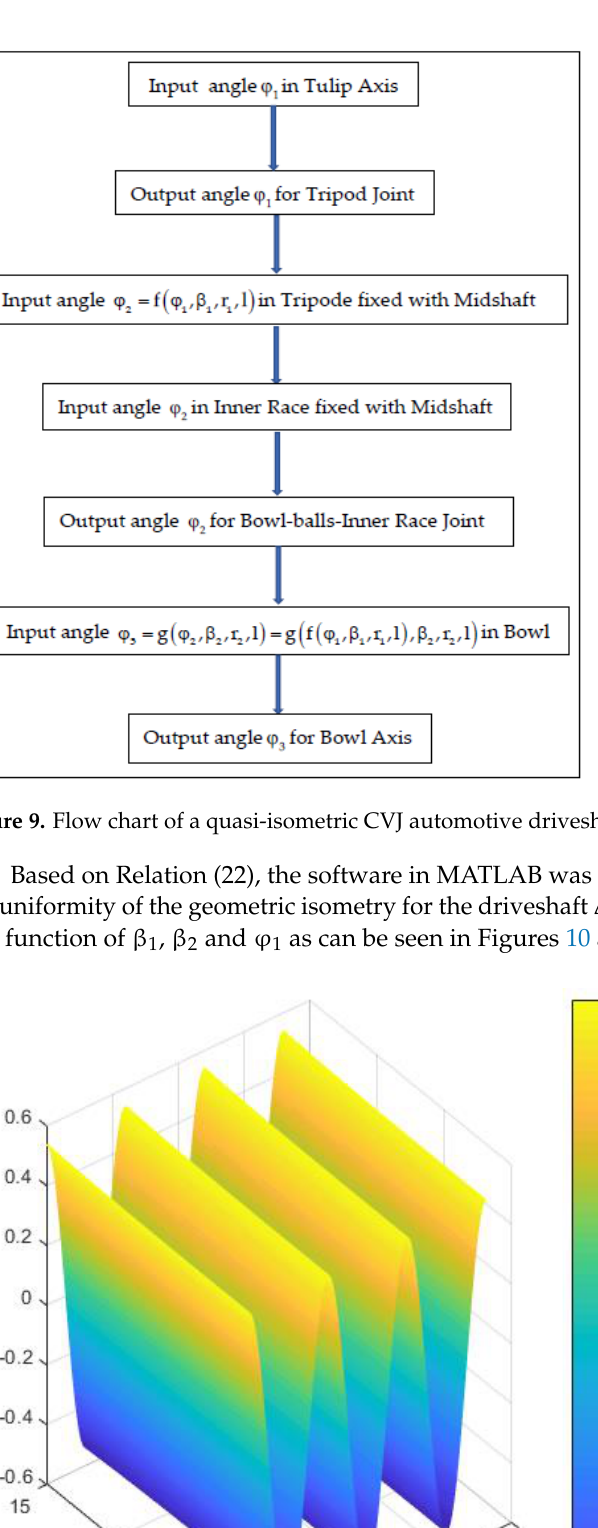
Figure 11. Geometrical nonuniformity of isometry for automotive driveshaft for r 1 /l = 0.11, r 2 /l = 0.09, β 2 = 47°.